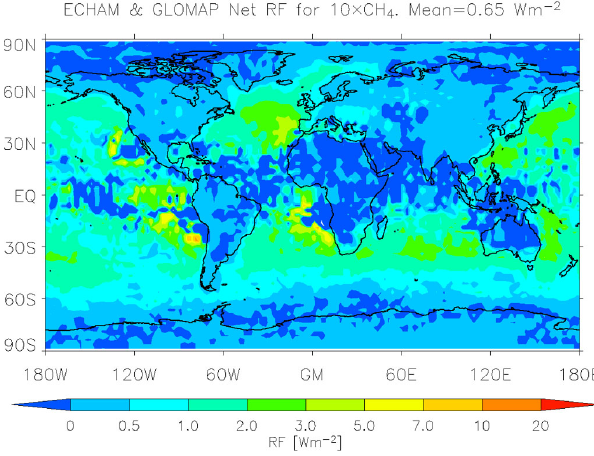
Fig. 5. Predicted cloud-albedo aerosol radiative forcing (in Wm − 2 ) associated with a CH 4 concentration increased by a factor of 10, using GLOMAP and E-S.